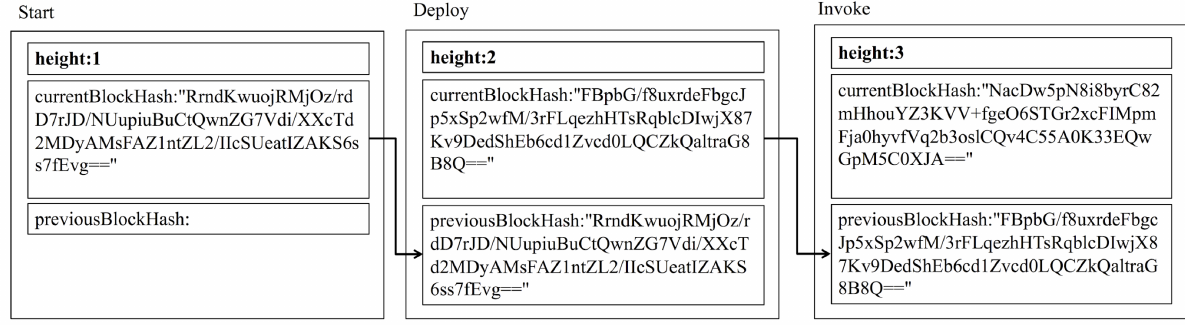
Figure 2. The blockchain (excerpt) in the normal mobile health data update.